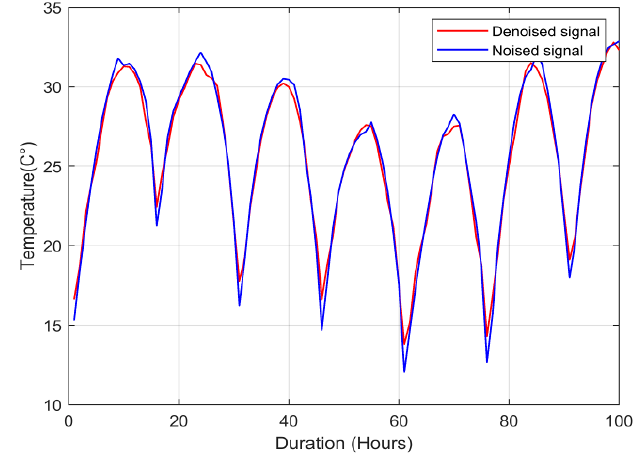
Figure 2. Application of PCA-based noise filtering to temperature data.